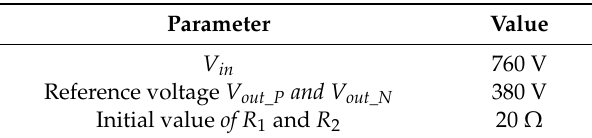
Table 1. Simulation parameters.